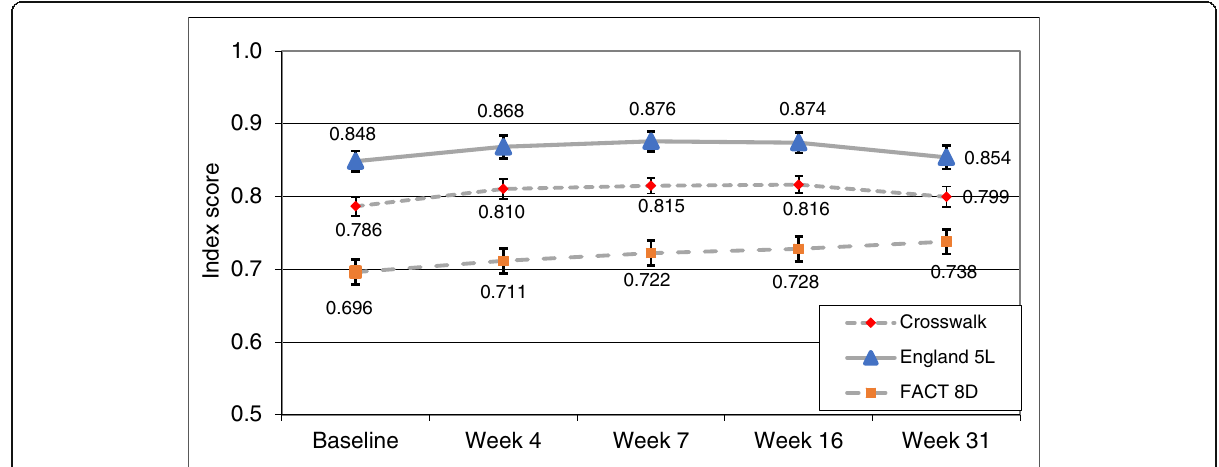
Fig. 1 Mean FACT-8D and EQ-5D-5L (Crosswalk and England value set) Index scores and standard errors by study visit for patients completing the assessment at week 31 ( n = 130)